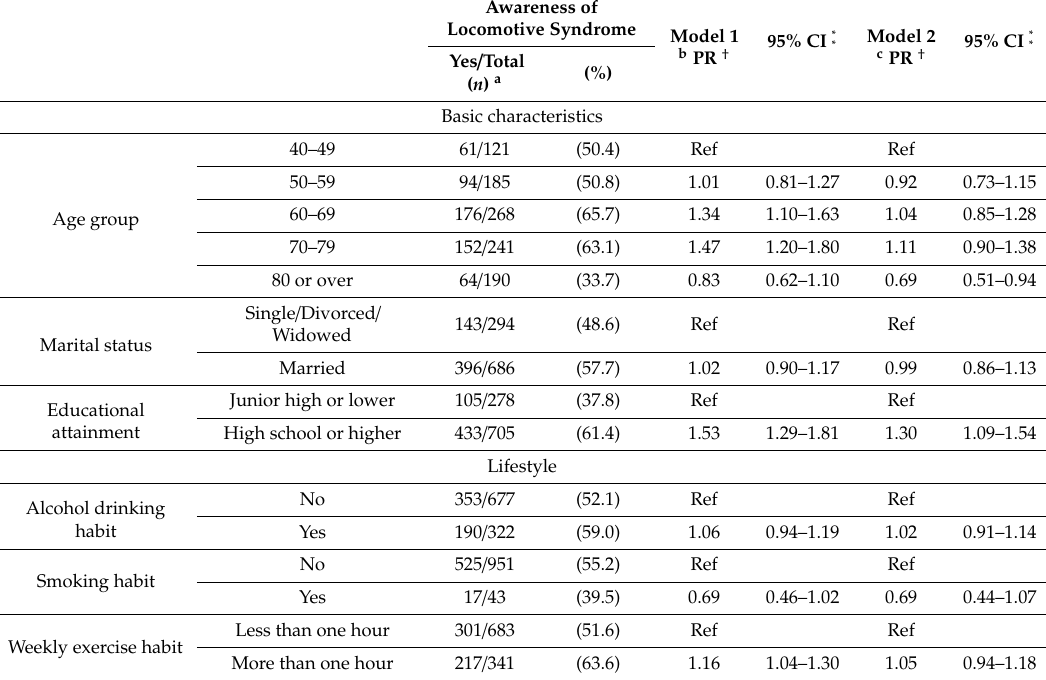
Table 2. Adjusted prevalence ratios of each covariates to increase awareness of locomotive syndrome in